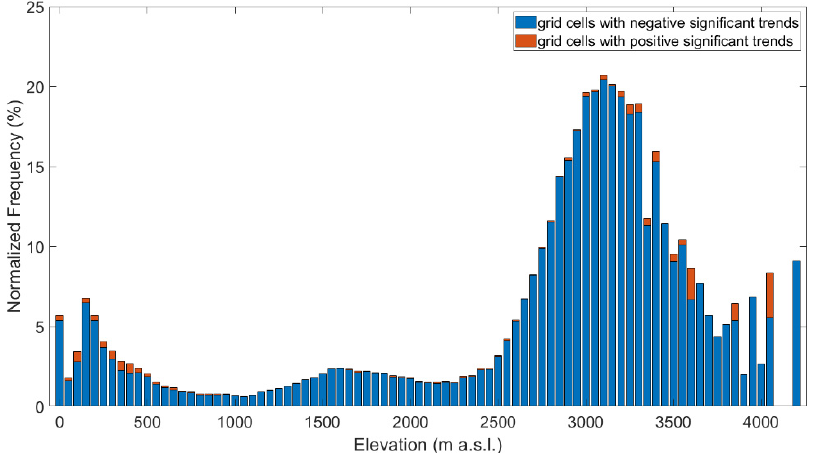
Figure 8. Frequency of negative and positive significant trends (95% confidence level) in the length of season (LOS) normalized by the number of grid cells in each elevation band in the Greater Alpine Region.